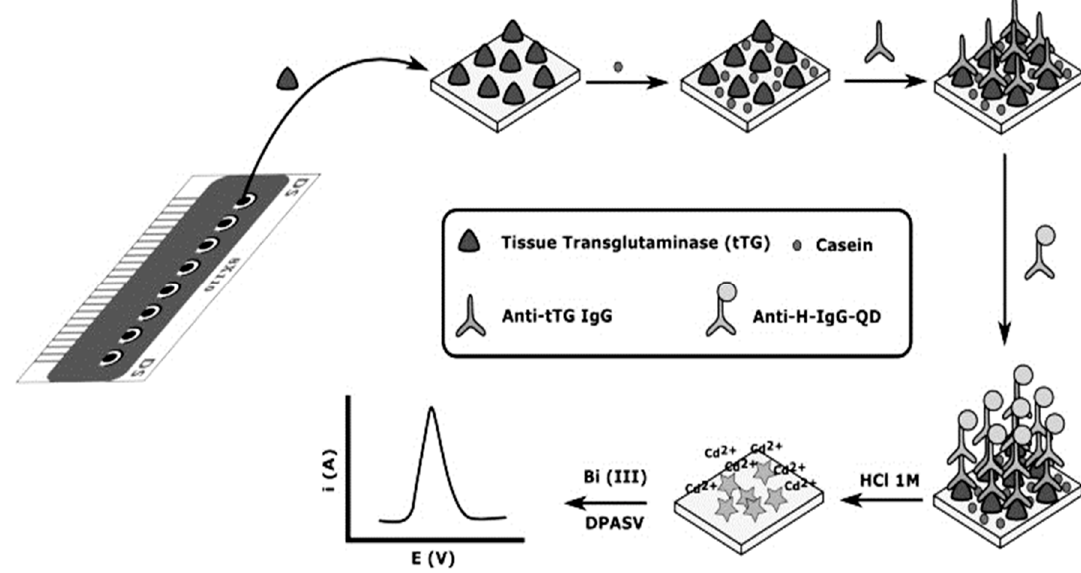
Figure 1. Schematic diagram of the electrochemical biosensor array. The bioassay is carried out using the working electrodes of the array as transducers and in situ electrochemical detection of QDs. Reprinted with Permission [22].